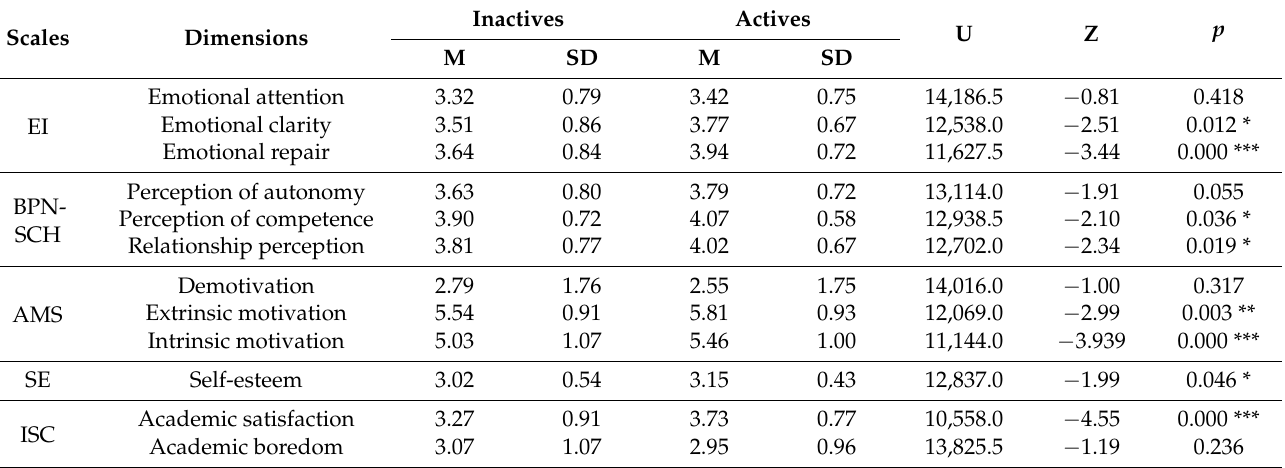
Table 3. Differences depending on the levels of physical activity during leisure time.